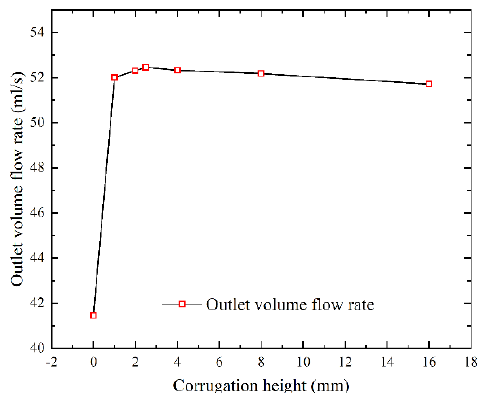
Figure 15. Relationship between the volume flow rate and corrugation height.